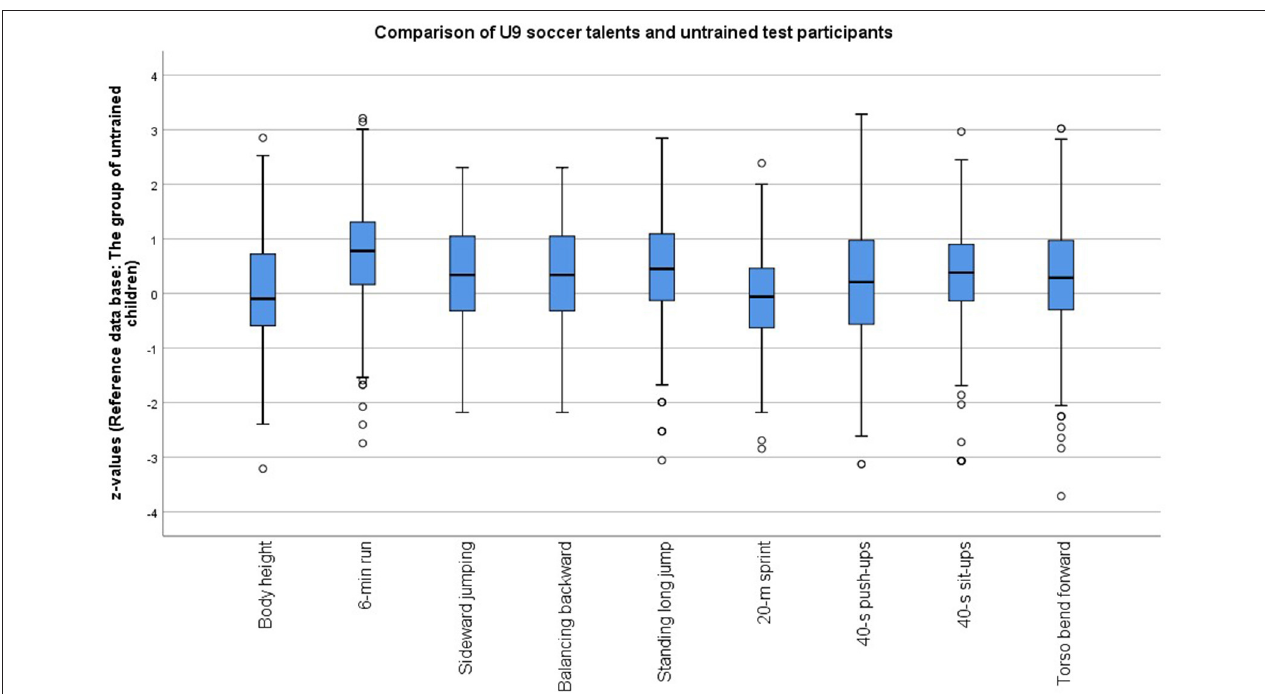
FIGURE 4 | Age-adjusted and z -standardized test performances of the soccer players and non-athletes of the second grade of elementary school in the test campaigns